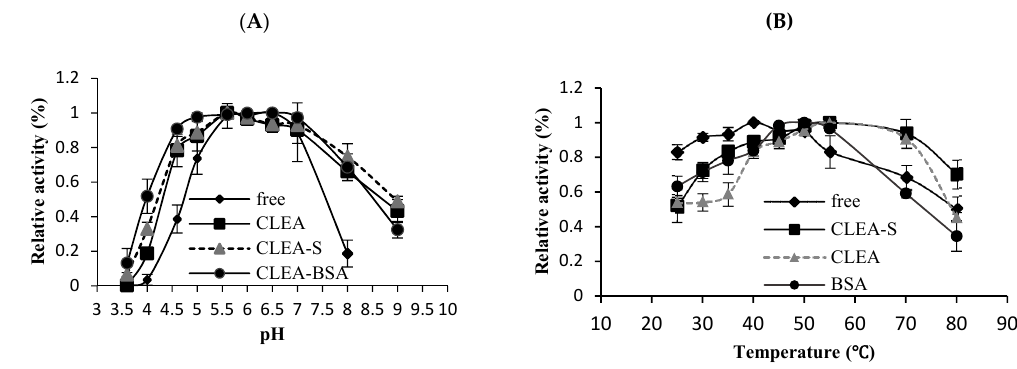
Figure 3. ( A ) pH profiles of the free and immobilized α -amylase. Rates of hydrolysis are expressed as percentage of the maximal activity. ( B ) Temperature dependence of native and immobilized α -amylase. Rates of hydrolysis are expressed as percentage of the maximal activity.